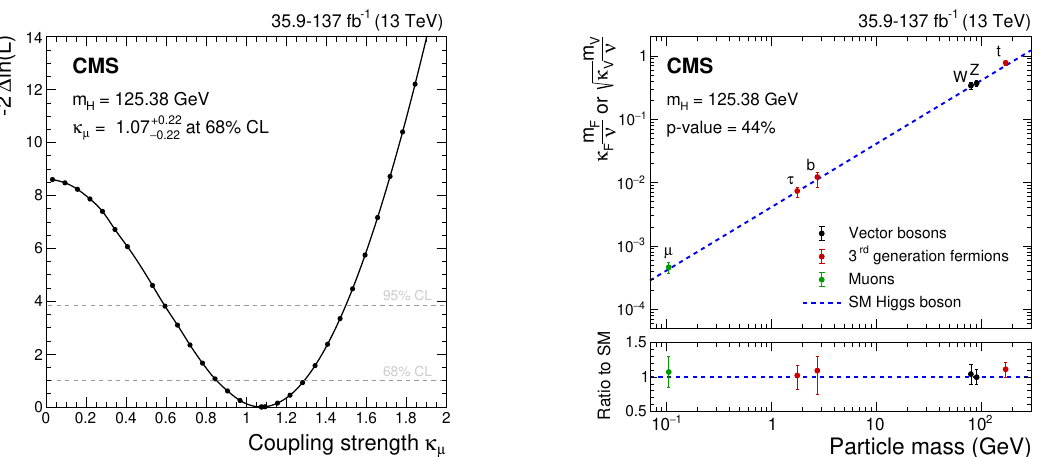
Figure 14 . Left: the observed profile likelihood ratio as a function of κ obtained from a combined fit with ref. [10] in the κ -framework. The best fit value for κ and the corresponding observed 68% CL interval is 0 . 85 < κ for the reduced coupling modifiers extracted for fermions and weak bosons from the resolved κ - framework compared to their corresponding prediction from the SM. The error bars represent 68% CL intervals for the measured parameters. In the lower panel, the ratios of the measured coupling modifiers values to their SM predictions are